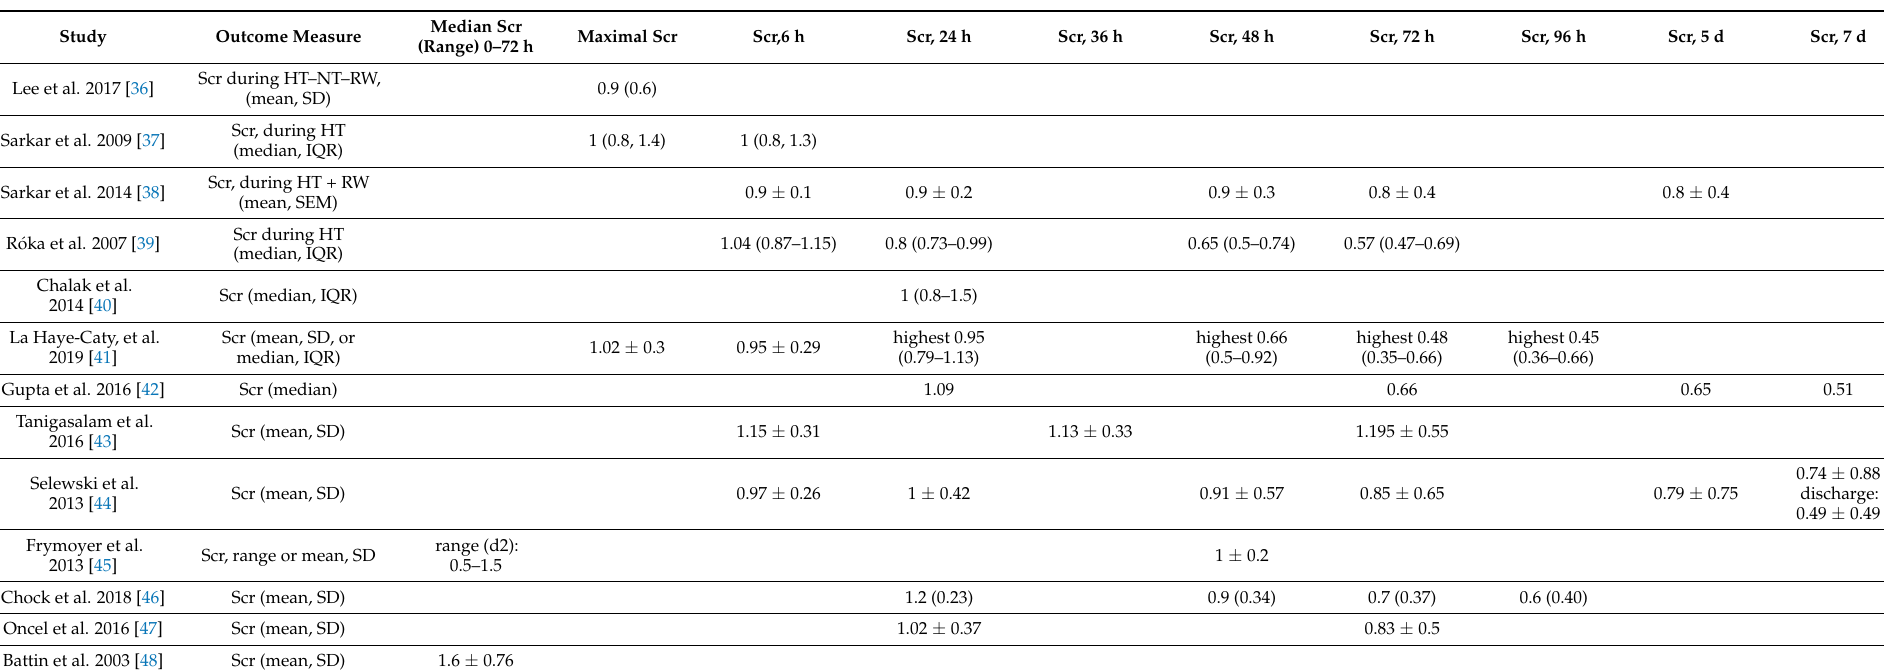
Table 4. Serum creatinine (Scr) values as reported in the retained studies of this meta-analysis (HT: hypothermia; RW: rewarming; NT: normothermia; SD: standard deviation, IQR: interquartile range)